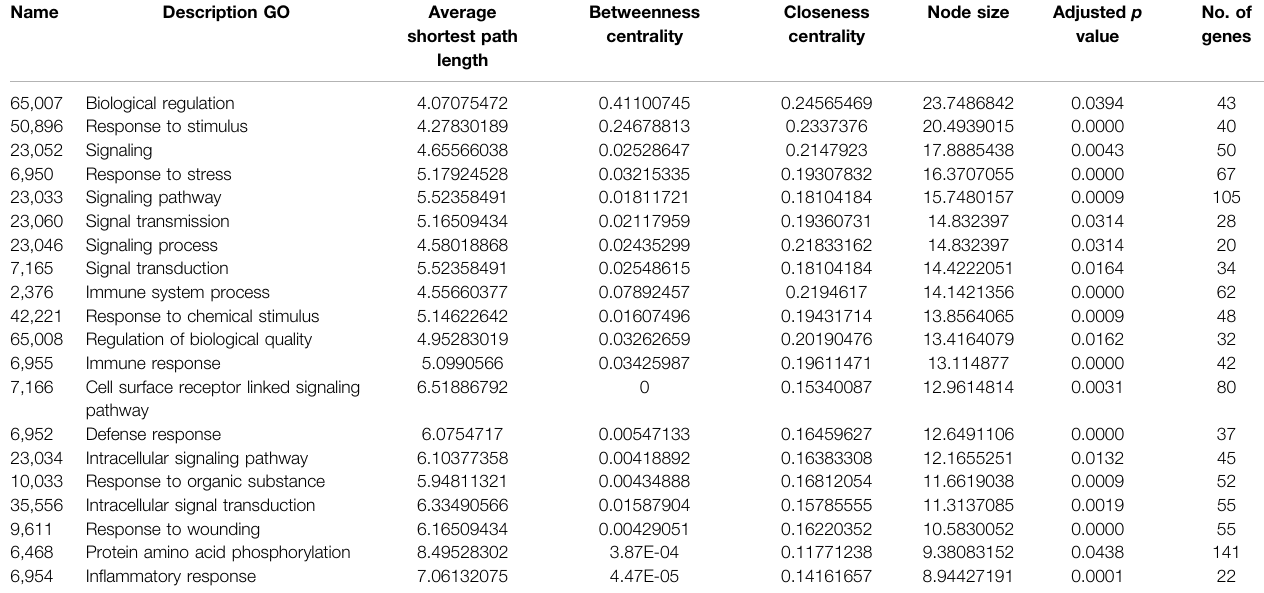
TABLE 6 | List of top 20 signi fi cantly overrepresented GO categories derived from the BINGO analysis output, based on our data. The list has been arranged in descending order of node size.